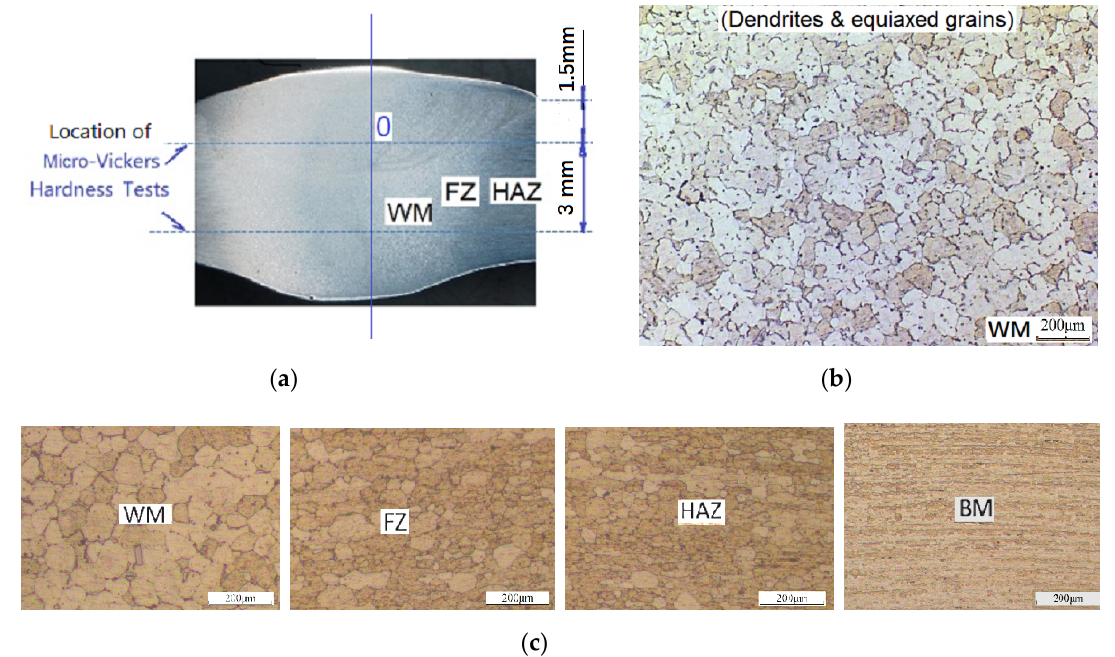
Figure 5. Metallographs and morphologies of the joint with each local zone. ( a ) Location for the hardness tests; ( b ) Microstructure of the WM; ( c ) Metallographs and morphologies of the WM and each local zone.